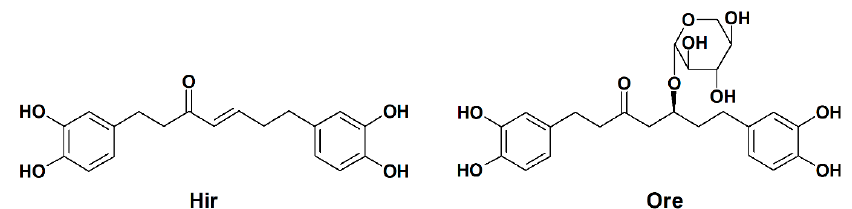
Figure 1. Chemical structures of Hir and Ore.